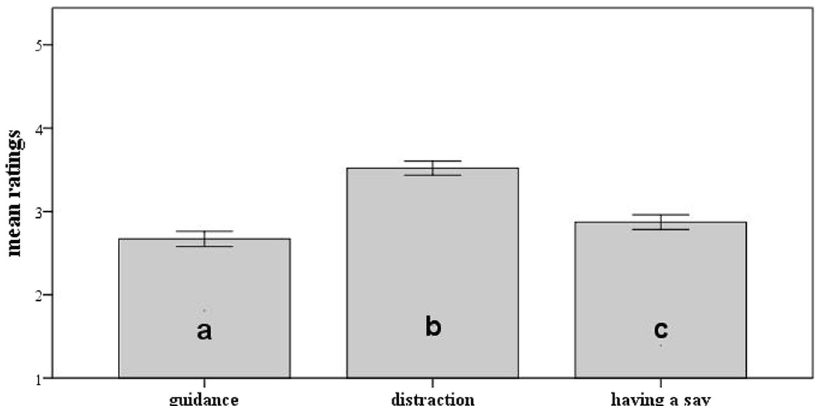
Fig. 4 Mean ratings for each of the three components re fl ecting participants ’ motivations for reading erotic novels. Error bars indicate the standard error of the mean. Means with different letters are signi fi cantly different.